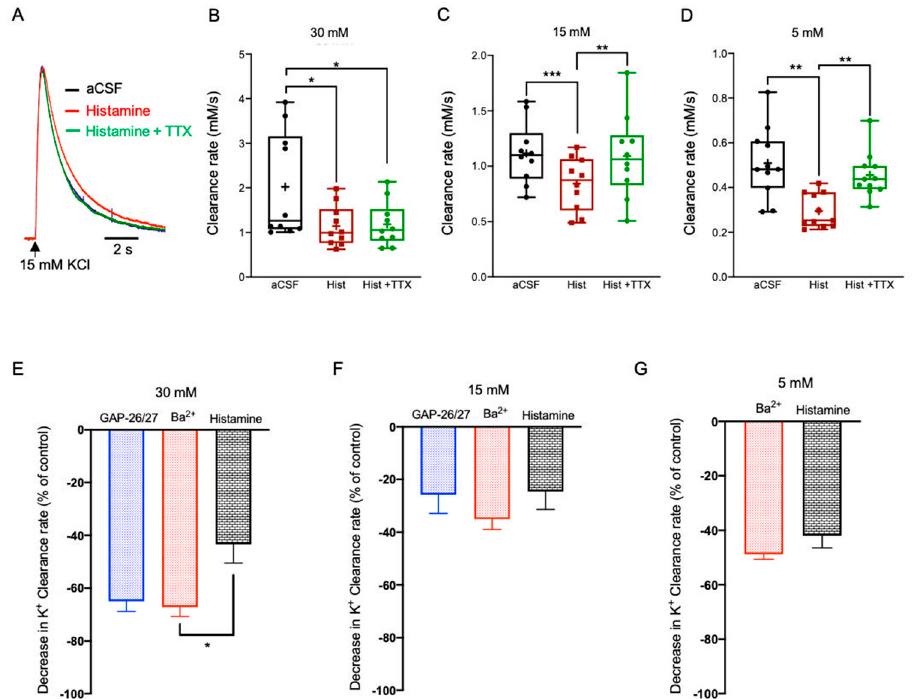
Figure 6. The impact of Histamine on the K + clearance rate and astrocytic Ca 2+ signaling. ( A ) Sample traces of [K + ] o recordings depicting the K + clearance time course following local application of 15 mM KCl (arrow), before (aCSF, black) and after bath application of Histamine dihydrochloride (50 µ M, red) or Histamine with 1 µ M TTX (green). ( B – D ) Box plots depicting the K + clearance rate following local application of KCl at 30 mM ( B ), 15 mM ( C ) and 5 mM ( D ), before (aCSF, black dots) and after bath application of Histamine dihydrochloride (50 µ M) without (red dots) or with TTX (green dots). ( E – G ) Bar graphs depicting the average decrease in K + clearance rate (as % from control) following blockade of Kir4.1 channels by Ba 2+ (red); blockade of Cx43 channels by a mix of GAP26/27 mimetic peptides (blue), or photolysis of DA (black) together with the local application of 30 mM ( E ), 15 mM ( F ) or 5 mM ( G ) KCl. Box plot definitions is the same as in Figure 1. * p < 0.05; ** p < 0.01; *** p < 0.0001; two-way